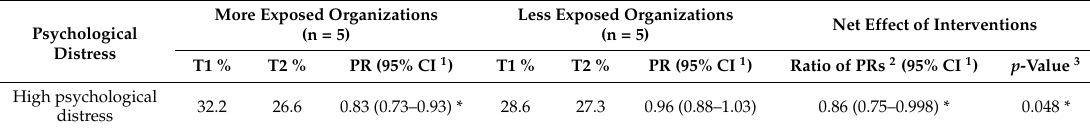
Table 4. Prevalence (%) and prevalence ratios (PR) of high psychological distress according to organizations’ exposure to interventions in the Management Practices area of the QHES 1 , before (T1) and after (T2) QHES 1